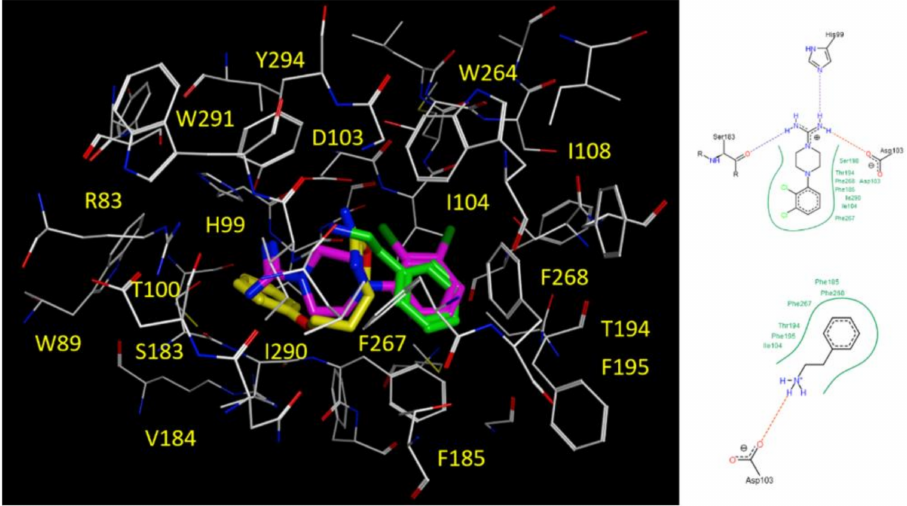
Figure 14. Docking positioning of potent oxazoline 20b ( C atom; yellow), of the amidine-containing derivative 15 ( C atom; magenta) and of the endogenous agonist β -PEA ( C atom; green) as h TAAR1-targeting compounds ( left ). Ligands are shown as sticks. The most relevant residues are labelled. A schematic perspective of the most relevant H-bonds experienced by 15 and β -PEA is also shown ( right